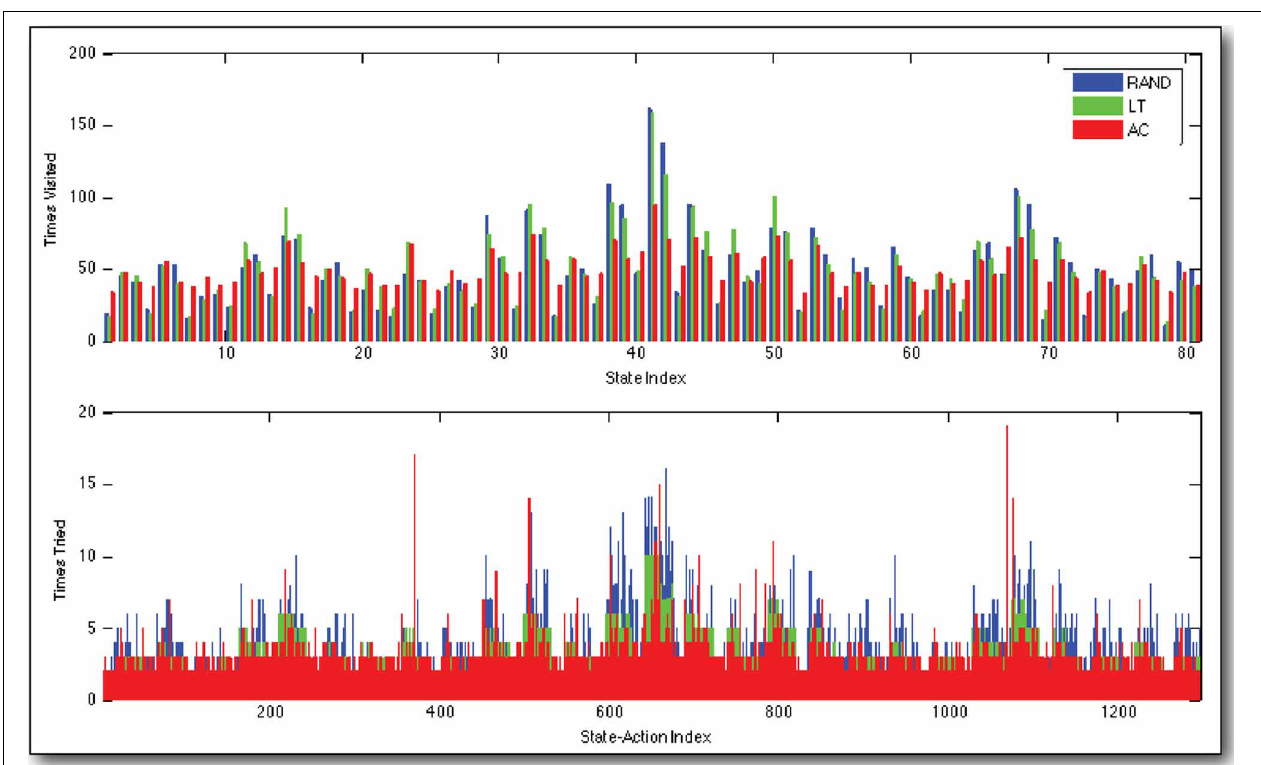
FIGURE 5 | Distributions of visits over states and tries over actions. Our curious agent (AC) visits states and tries actions in a more uniformly than to policies based on random exploration (RAND) and always selecting the least tried state-action (LT). Note the few state-actions, which have been tried many times by AC. These are